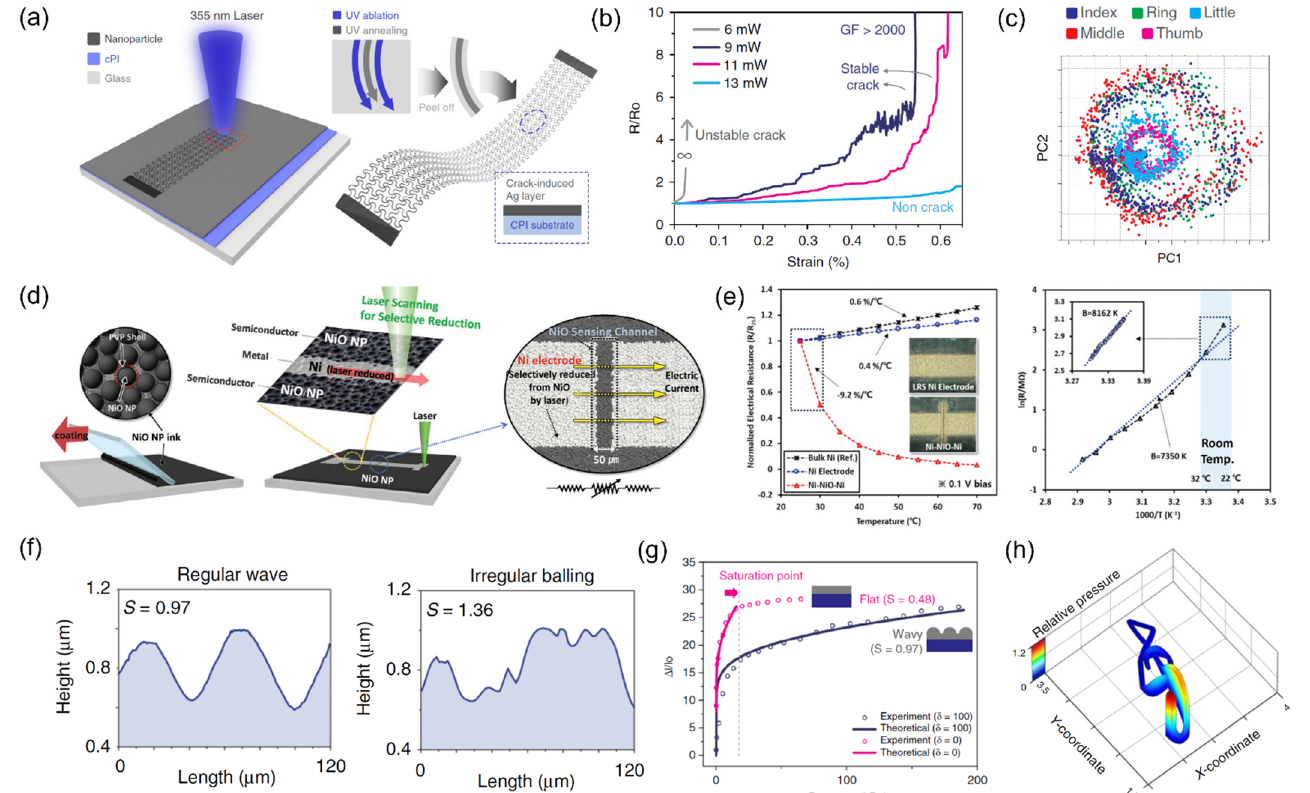
Figure 4. ( a ) Laser-induced crack based skin sensor. ( b ) Strain-dependent resistance of the sensors created at different laser power. ( c ) 2D PCA illustration obtained from the encoding network, showing that finger motions can be identified correctly. Reprinted with permission from Ref. [106]. ( d ) Process illustration for monolithic laser reductive sintering. (m-LRS) ( e ) (Left) Temperature-dependent electrical resistance change of the Ni-NiO-Ni structure and (Right) B-value fitting. Reprinted with permission from Ref [109]; 2019 Wiley-VCH Verlag GmbH & Co. KGaA, Weinheim, Germany; ( f ) Surface profile of the regular wavy structure and irregular balling created at different surface shaping number. (S) ( g ) Resistance responses of flat and wavy structure according to the applied pressure. ( h ) 3D G-clef drawn on the transparent 3D touch device. Reprinted with permission from Ref. [110].